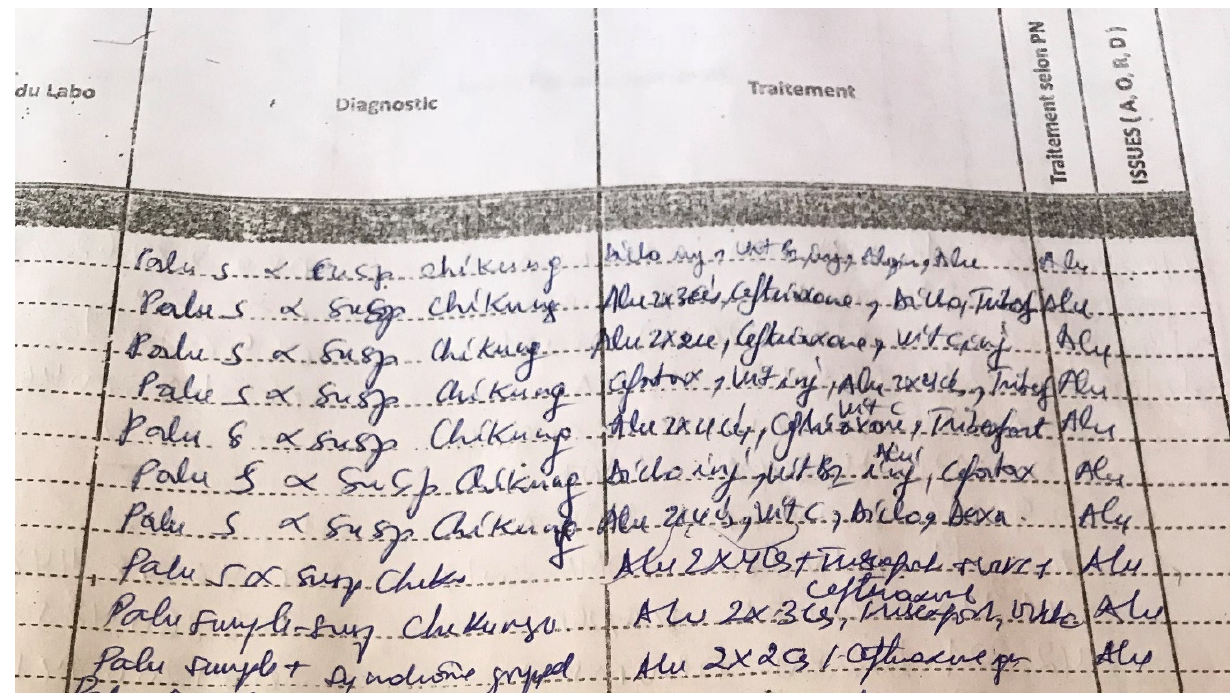
Figure 5. Snapshot—part of consultations of 28 February 2019—from a consultation register in the Matadi health zone.